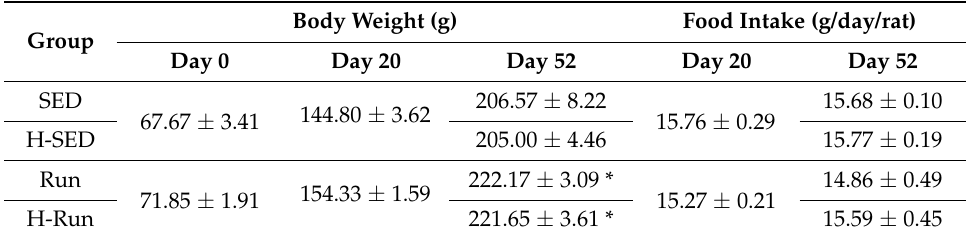
Table 1. Body weight of the animals at the beginning of the study, and before and after the five-week training program and hesperidin supplementation (day 20 and 52, respectively), and food intake before and after the five-week training program and hesperidin supplementation.